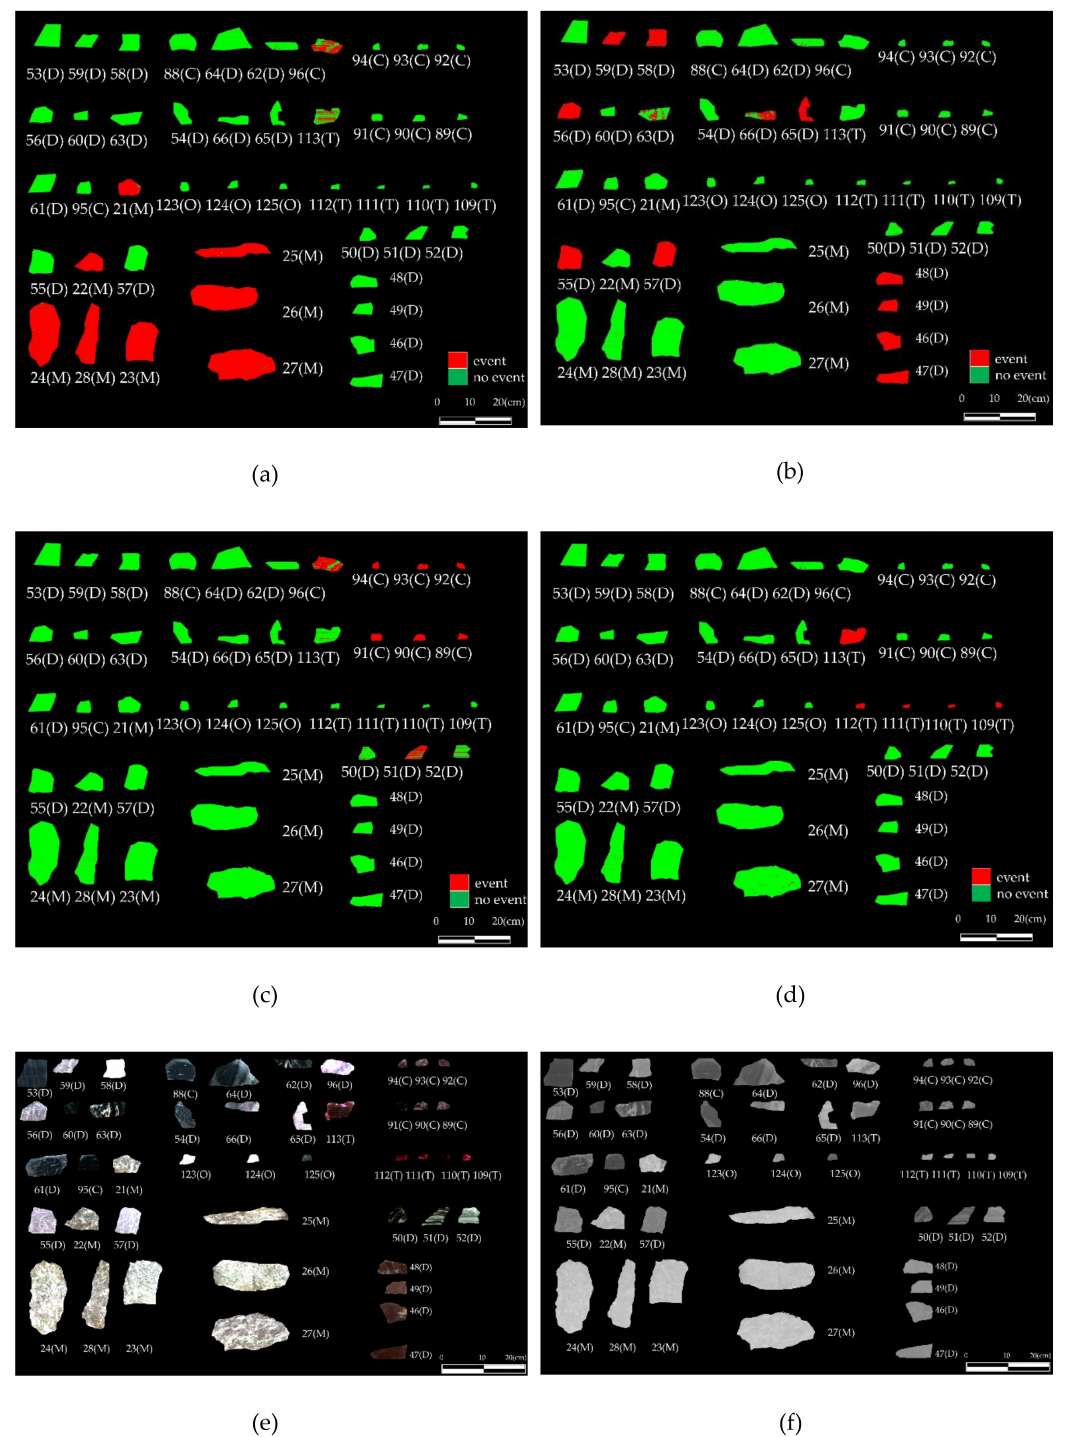
Figure 9. Classification images of the logistic regression models applied to the validation models of ( a ) magnesite, ( b ) dolomite, ( c ) calcite, and ( d ) talc; a Specim hyperspectral short wave infrared (SWIR) false color composite image (R:2250 nm; G:2283 nm; B:2433 nm) ( e ); and a gray scale image of the 2266 nm band ( f ) for the validation samples, where the sample label of M shows the magnesite sample, D the dolomite sample, C calcite, T talc, and O other